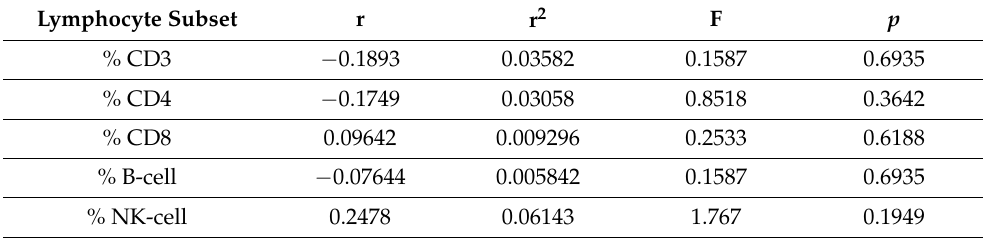
Table 3. CTC-number/lymphocyte fraction correlations 1 . Lymphocyte